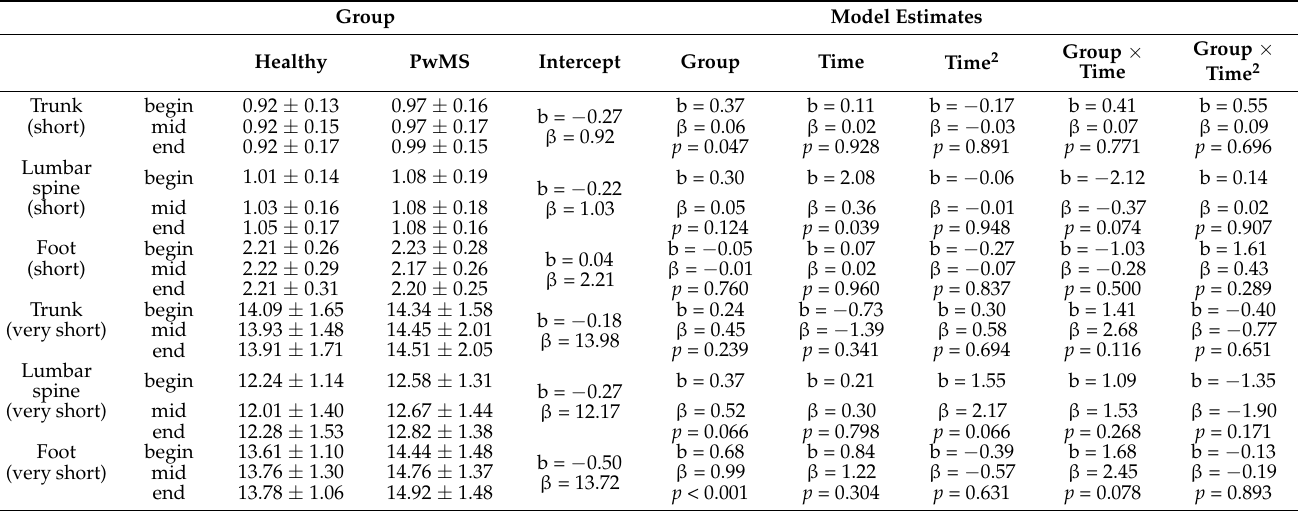
Table 2. LDE measures for healthy participants and PwMS. Mean ± standard deviation of measured local divergence exponent (LDE) for healthy participants and PwMS, separated for the first (begin), middle (mid) and last (end) 30 steps. β : model parameter estimate after z-transformation of the LDE